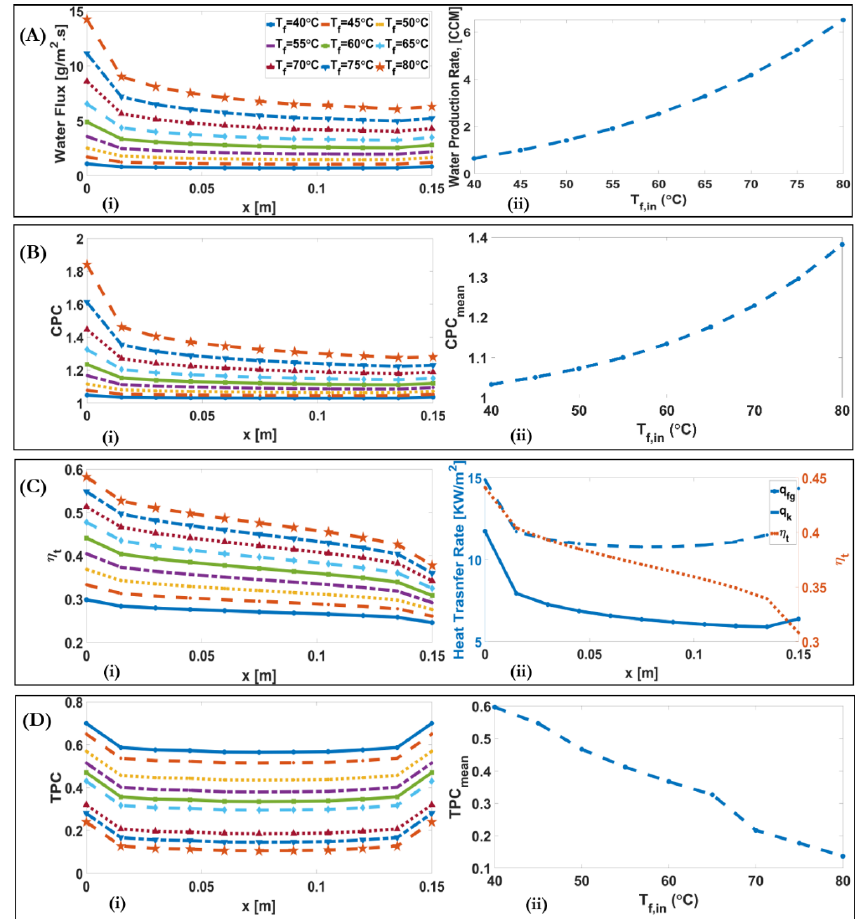
Figure 7. ( A ) ( i ) Downstream alterations of water flux for different inlet feed temperatures of a DCMD system. ( A ) ( ii ) . Alteration of water production rate with varying inlet feed temperatures of a DCMD system; ( B ) ( i ) Downstream alterations of CPC for different inlet feed temperatures of a DCMD system. ( B ) ( ii ) Alteration of maximum CPC with varying inlet feed temperatures of a DCMD system; ( C ) ( i ) Downstream alterations of 𝜂 𝑡 for different inlet feed temperatures of a DCMD system. ( C ) ( ii ) Conduction heat transfer ( 𝑞″ 𝑘 ), phase change ( 𝑞″ 𝑓𝑔 ), and thermal efficiency ( 𝜂 𝑡 ) of a DCMD system for the baseline condition; ( D ) ( i ) Downstream alteration of TPC for different inlet feed temperatures of a DCMD system, ( D ) ( ii ) Alteration of mean value of TPC with varying inlet feed temperatures.